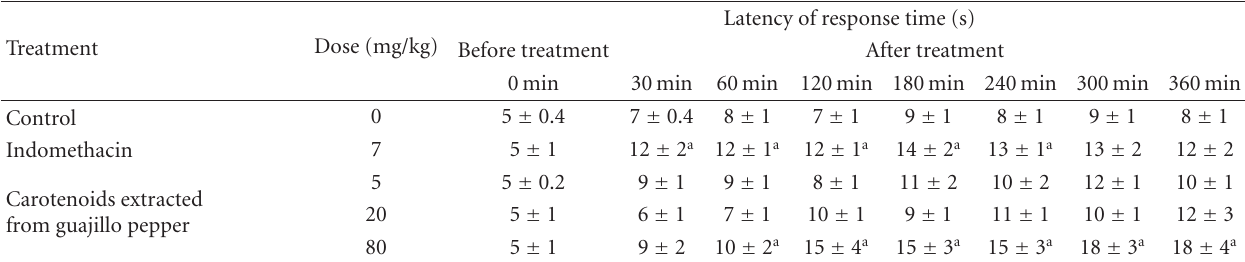
Table 5: Antinociceptive e ff ect of the carotenoid extract from guajillo pepper using a hot plate test on mice. Treatment